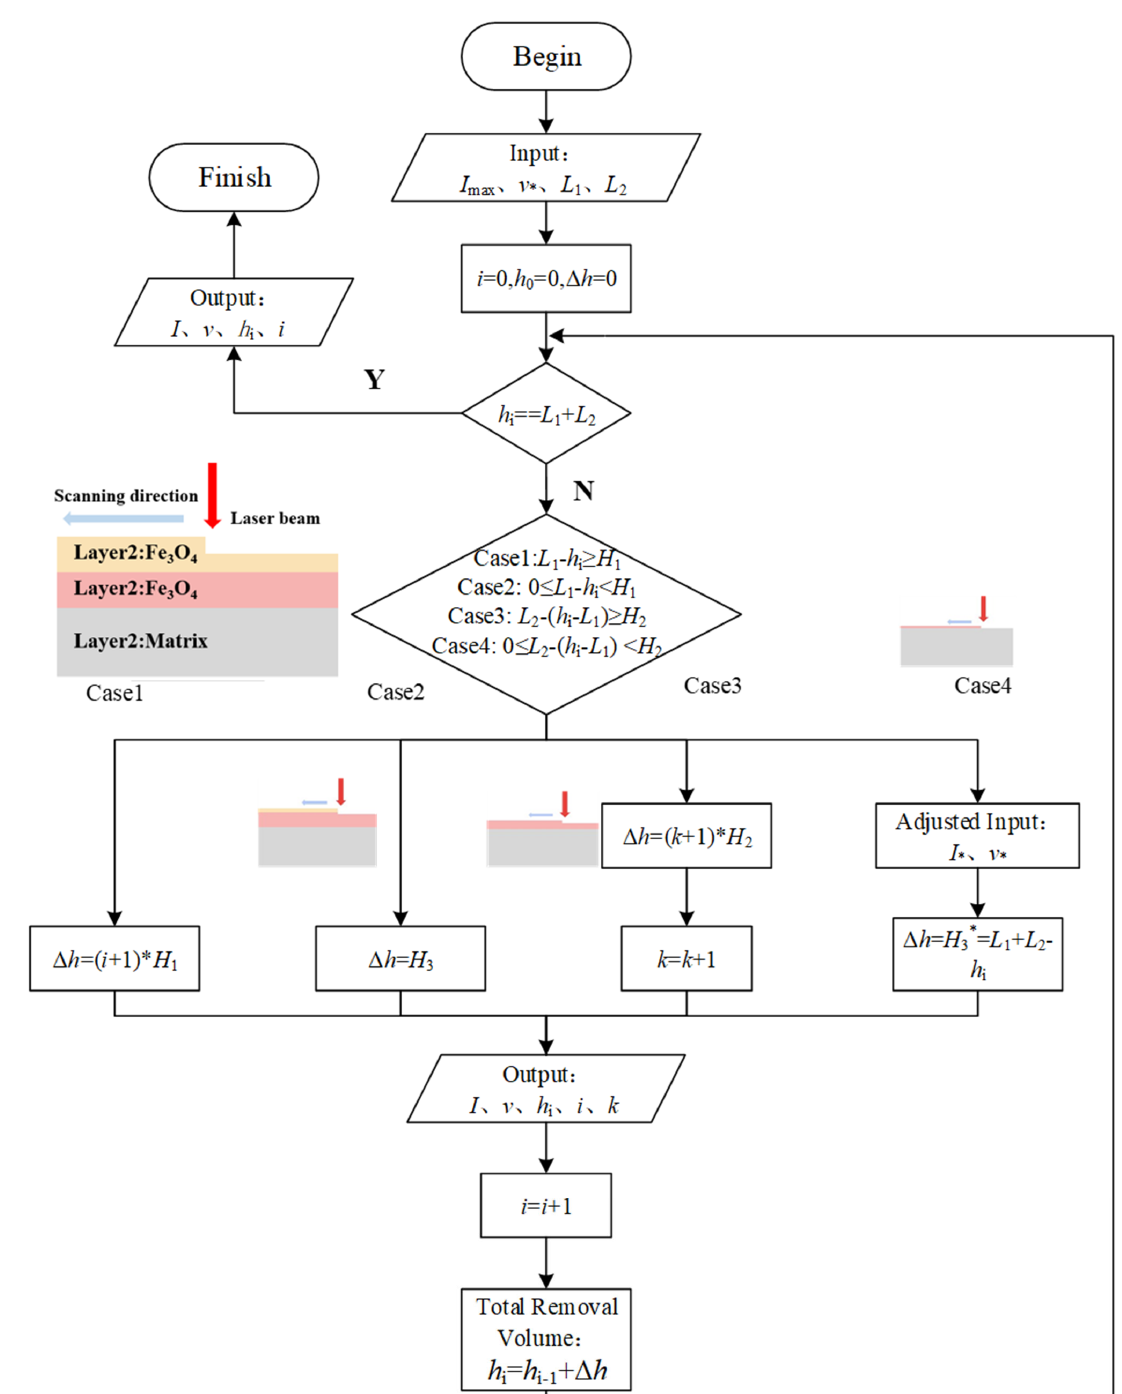
Figure 7 shows the flow chart of laser cleaning for rust-layered oxides. Imax, v*, L 1 , and L 2 input values represent the initial peak power density, initial scanning speed, and thickness of the Fe 2 O 3 layer and Fe 3 O 4 layer, respectively. Hi represents the total removal volume of laser cleaning. ∆ h represents the single removal volume of each stage. I* represents the peak power density adjusted during the last cleaning. The initial values of I, h 0 , and ∆ h were 0.